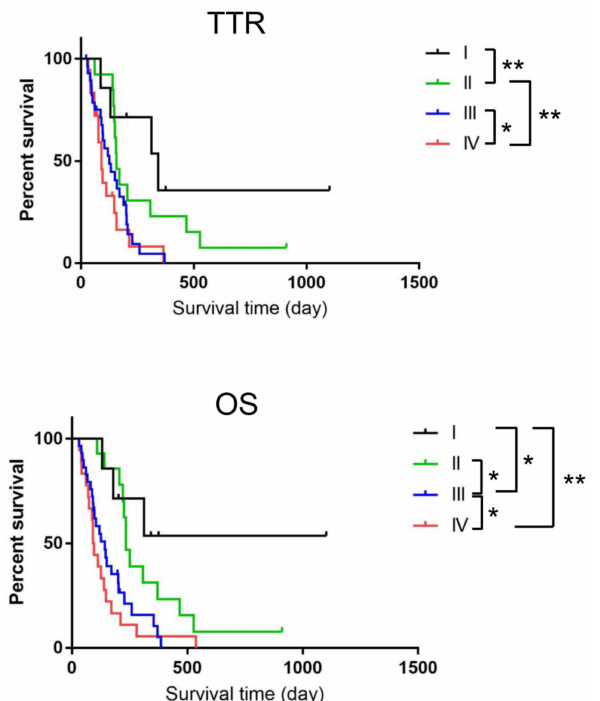
Figure 1. Kaplan–Meier survival curves of the dogs with oral melanoma, evaluated on the basis of World Health Organization tumor stage (I ( n = 7), II ( n = 14), III ( n = 29), and IV ( n = 18). Significant differences were observed between the groups in brackets. * p < 0.05, ** p < 0.01. No significant differences were observed in TTR and OS (data not shown) in relation to tumor location. The median TTR and OS for dogs in relation to tumor size were as follows: TTR, TI, 158 days; T2, 148 days; and T3, 126 days; and OS, T1, 312 days; T2, 234 days; and T3, 145 days (Figure 2a). The log-rank test revealed a significant difference between T1 and T3 in the TTR and each group, except for T1 and T2, in the OS. Cytoreduction by debulking surgery significantly affected the TTR and OS: the TTR was 179.5 days with cytoreduction and 119 days without cytoreduction, while the OS was 312 days with cytoreduction and 148 days without cytoreduction (Figure